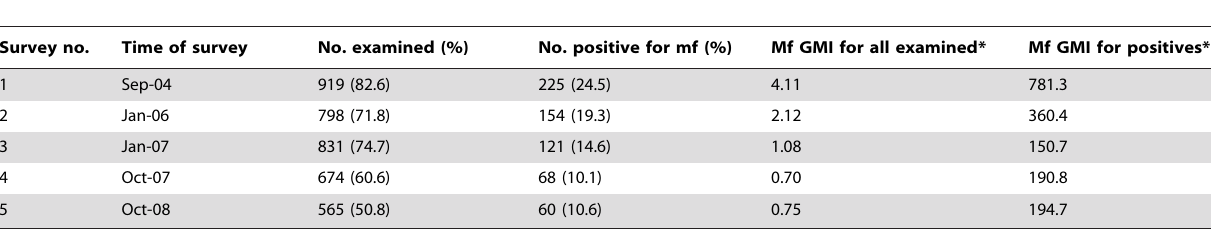
Table 4. Microfilaraemia in Kirare village during the pre-MDA survey (September 2004) and the four post-MDA surveys (January 2006, January 2007, October 2007 and October 2008). Survey